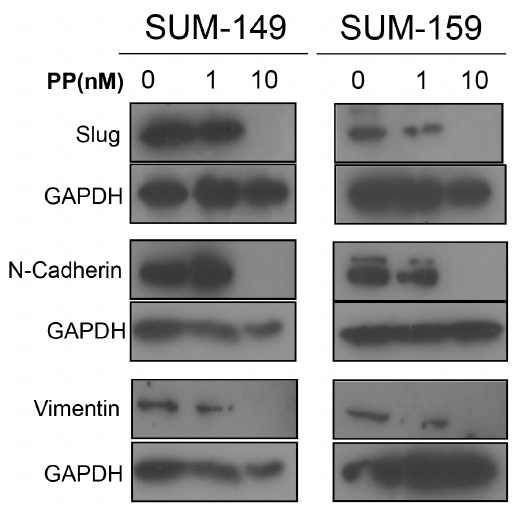
Figure 7. EMT markers were down-regulated in SUM-149 and SUM-159 cells treated with PP. SUM-149 and SUM-159 cells were treated with different doses of PP for 96 hours followed by Western blotting analysis using antibodies targeting different EMT markers. Slug, N-cadherin, and vimentin were down-regulated by 10 nM PP. The results shown are representative of three independent experiments.